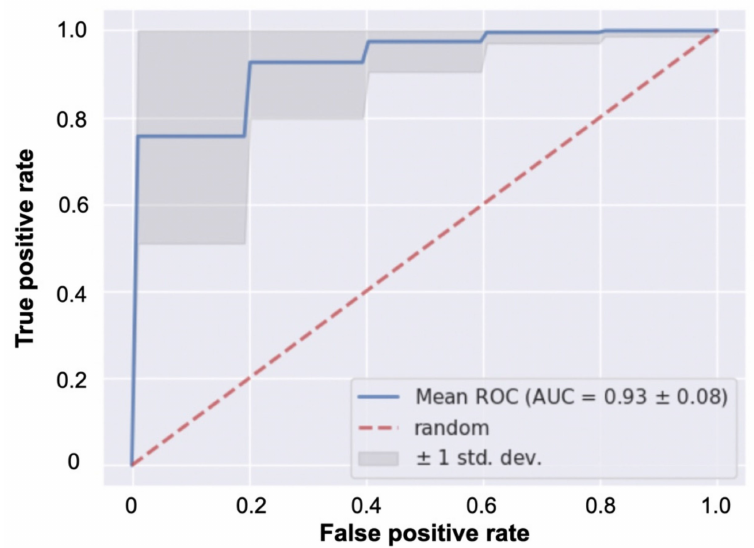
Figure 5. Mean receiver operating characteristic (ROC) curve of the classifier for Groups A and B with good and poor visual acuity over time during maintenance treatment. The standard deviation (SD) was equivalent to the SD of the area under the ROC curve (AUC) obtained by evaluating the model 100 times with the test